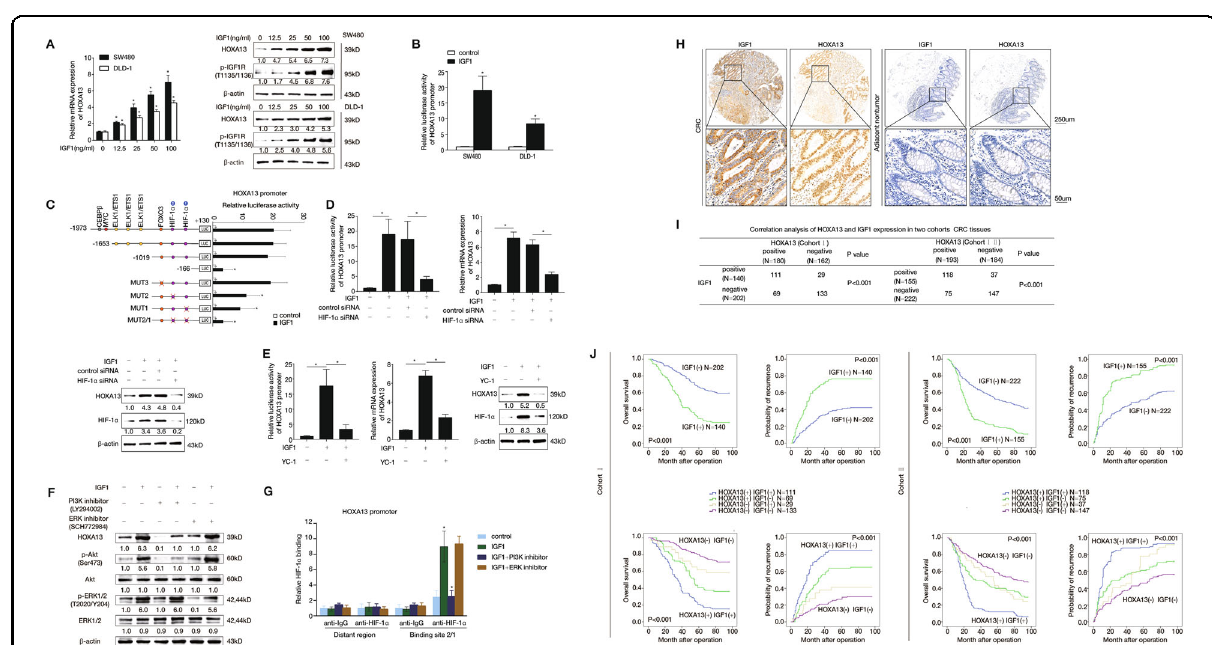
Fig. 3 IGF1-IGF1R upregulates HOXA13 expression via PI3K/AKT/HIF1 α pathway. A SW480 and DLD-1 cells were administrated with gradient concentrations of IGF1 for 24 h, and then the mRNA and protein levels of HOXA13 and p-IGF1R were examined by real-time PCR and western blotting. B Relative luciferase activities were detected in SW480 cells and DLD-1 cells, which were transfected with plasmid constructs containing HOXA13 promoter after IGF1 treatment (50 ng/mL, 24 h). C Deletion and selective mutation analysis showed that two HIF1 α binding regions within the HOXA13 promoter were responsible for IGF1-induced HOXA13 promoter transactivation. D Knockdown of HIF1 α through HIF1 α siRNA reduced IGF1-mediated HOXA13 expression, which were detected by luciferase reporter assay (upper), real-time PCR (upper), and western blotting analyses (lower). E HIF1 α inhibitor YC-1 reduced IGF1-mediated HOXA13 expression. The promoter activity (left), mRNA expression (middle), and protein expression (right) of HOXA13 were examined when SW480 cells were treated with or without IGF1 (50 ng/mL, 24 h) in the presence of YC-1. F The protein expression of HOXA13, phosphorylated and total Akt and ERK1/2 were detected by western blotting when SW480 cells were pretreated with inhibitors of ERK1/2 (SCH772984) or PI3K (LY294002), and then were treated with IGF1 (50 ng/mL, 24 h) or not. G The ChIP assay showed the direct binding abilities of HIF1 α to the HOXA13 promoter induced by IGF1, and PI3K inhibitor reduced the binding abilities of HIF1 α to the HOXA13 promoter. H The expression of IGF1 and HOXA13 in CRC and adjacent nontumor tissues by IHC analysis. I The correlation analysis between IGF1 and HOXA13 in two independent cohorts. J Kaplan – Meier ’ s analysis showed the correlation between HOXA13/IGF1 expression and overall survival or recurrence in two independent cohorts. * P < 0.05, ** P < 0.01. Data are displayed as the mean ±